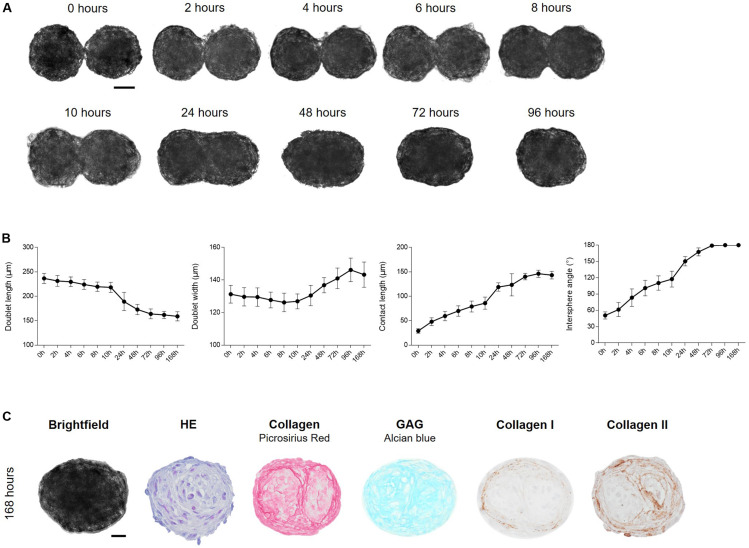
Fusion of cartilage microtissue doublets. (A) Cartilage microtissues at maturation stage of 7 days were harvested and doublets were formed. Spheroid fusion was tracked for 168 h by light microscopy. Scale bar 50 μm. (B) Morphological parameters such as doublet length (μm), doublet width (μm), contact length (μm), and intersphere angle (°) were measured using Image J software. (n = 12, all data are presented as mean ± 95% CI). (C) Morphological and (immuno)histochemical evaluation of fused doublets after 168 h of culture. HE staining was performed to assess overall morphology, Alcian Blue staining showed the presence of glycosaminoglycans (GAG). Collagen was visualized by Picrosirius Red (PSR) staining and IHC stainings for collagen type I and type II were performed. Scale bar 20 μm.